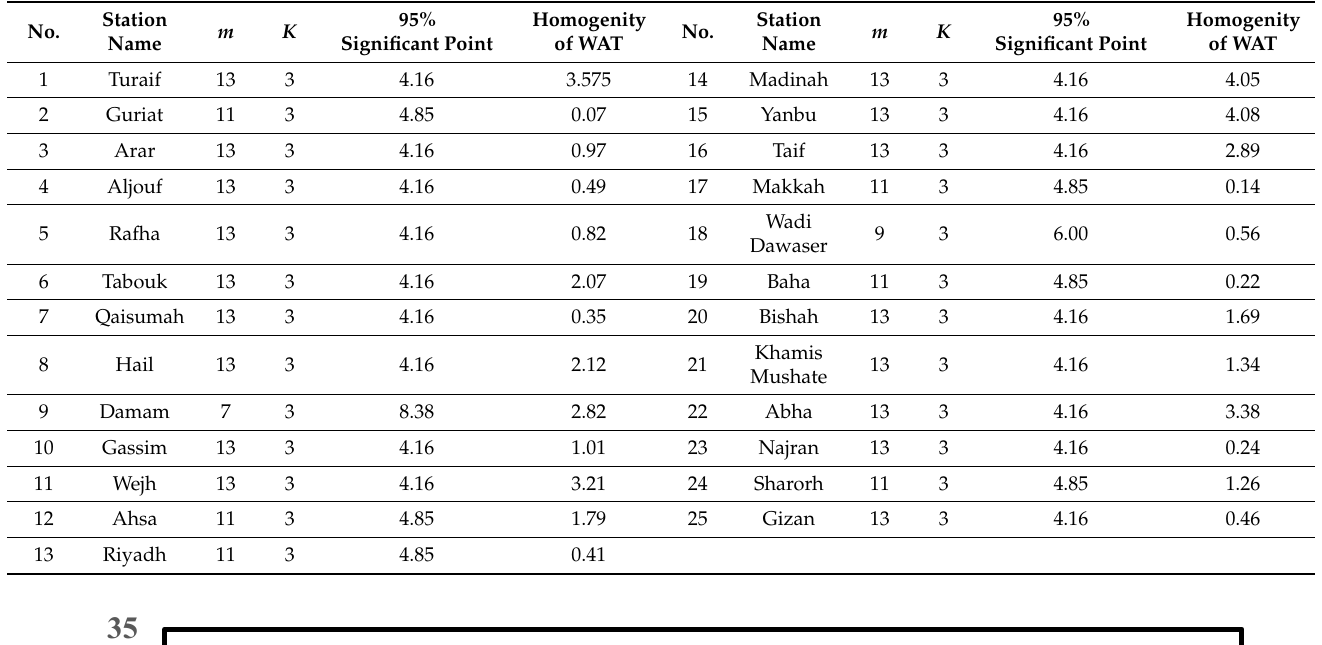
Table 2. Bartlet test (short-cut) result of the Winter Air Temperatures for Saudi Arabia stations ( m is the number of terms in each subperiod, and k is the number of the subperiod).